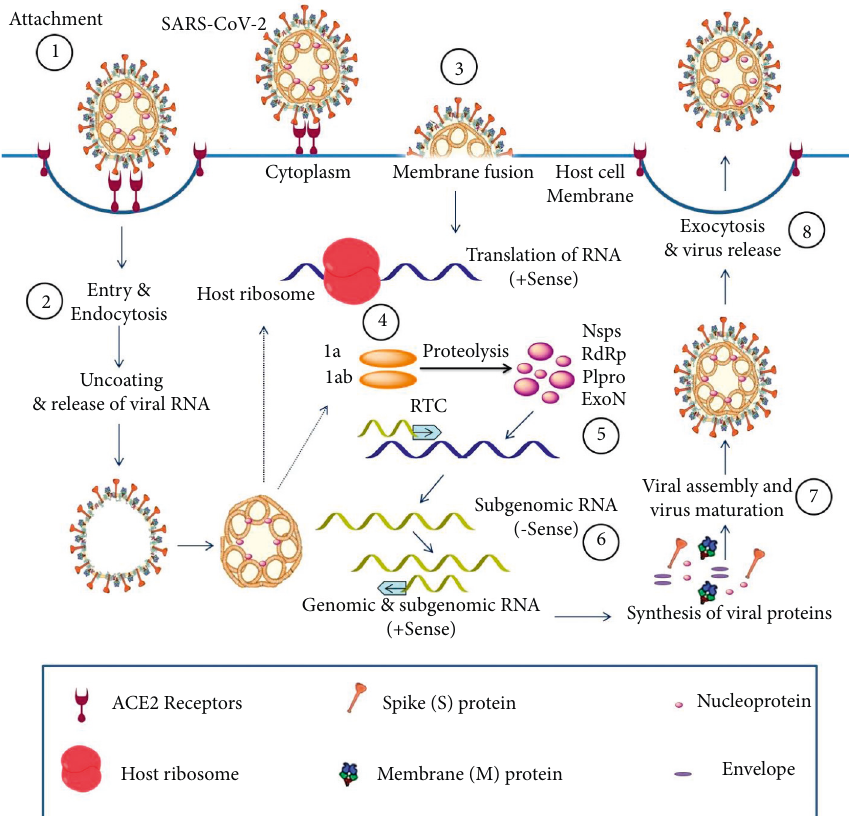
Figure 2: Mode of host entry and infective life cycle of severe acute respiratory syndrome coronavirus-2 (SARS-CoV-2) virus. (1) The interaction between the angiotensin-converting enzyme 2 (ACE2) receptor and S-protein leads to the attachment of the virus (2) The entry of virus conducted by endocytosis and/or by (3) Membrane fusion of virus (4) Translation of virus RNA leads to produce proteins 1a & 1ab (5) Proteolysis of proteins results in nonstructural proteins and replicase-transcriptase complex (RTC) (6) Synthesizing the new viral RNA (-sense) and the viral proteins (7) The association of the viral particle (8) Release of virus through